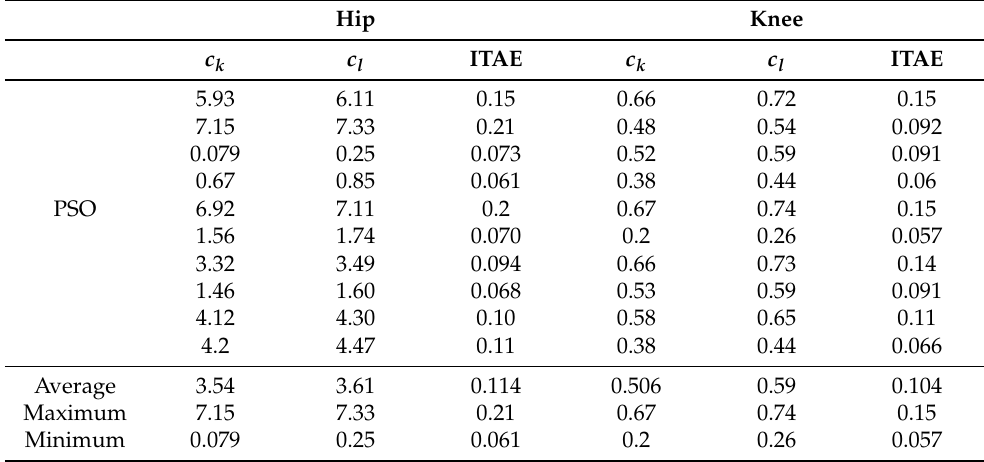
Table 5. Numerical analysis of PSO, GA, and BAS to tune the LAC